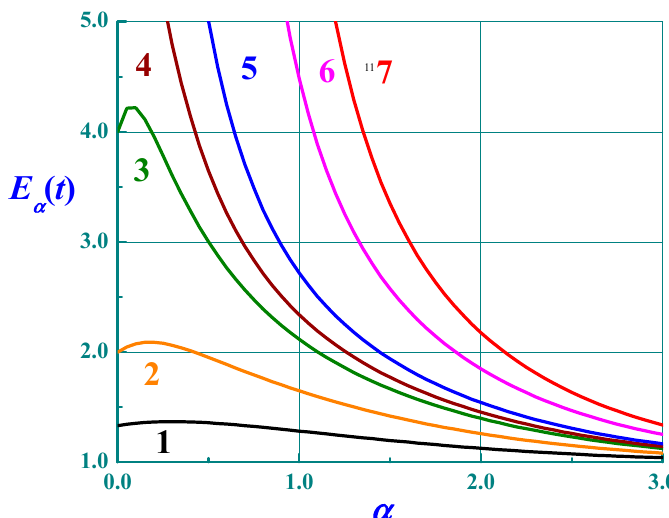
Figure 1. The Mittag-Leffler functions E α ( t ) as a function of α at constant values of argument t . 1—0.25; 2—0.50; 3—0.75; 4—0.85; 5—1.0; 6—1.5; 7—2.0.